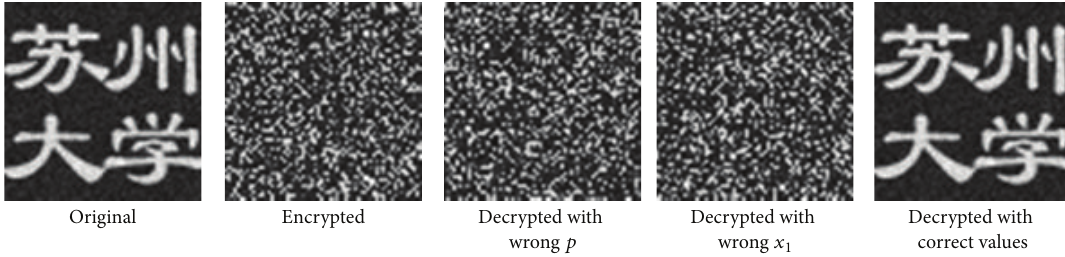
Figure 1: Illustration of PWLCM with different cases.